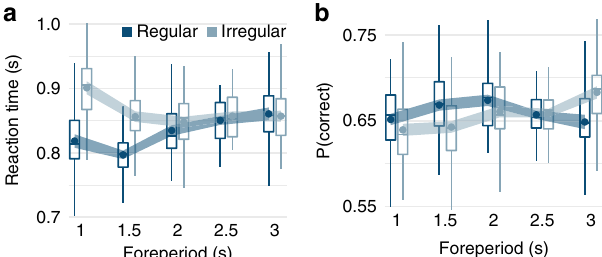
Fig. 2 Task performance and temporal predictability. Effects of temporal predictability condition (dark blue, regular; light blue, irregular) and foreperiod ( x -axis) on a reaction times and b proportions of correct responses. Boxplots indicate the distribution of participant-level mean values per condition adjusted by their overall mean (center line, median; box limits, upper and lower quartiles; whiskers, minimum and maximum limited by 1.5× interquartile range). Circular markers show group-level mean values; the width of the ribbon around each marker equals the predictability-condition-adjusted standard error, which indicates the degree of intersubject variation in the difference between regular and irregular conditions, and therefore whether there is an effect of predictability condition on the dependent variable. All statistics are based on the full dataset ( N = 30 participants, 100 repetitions per each of the 10 conditions and participant), and source data are provided as a Source Data